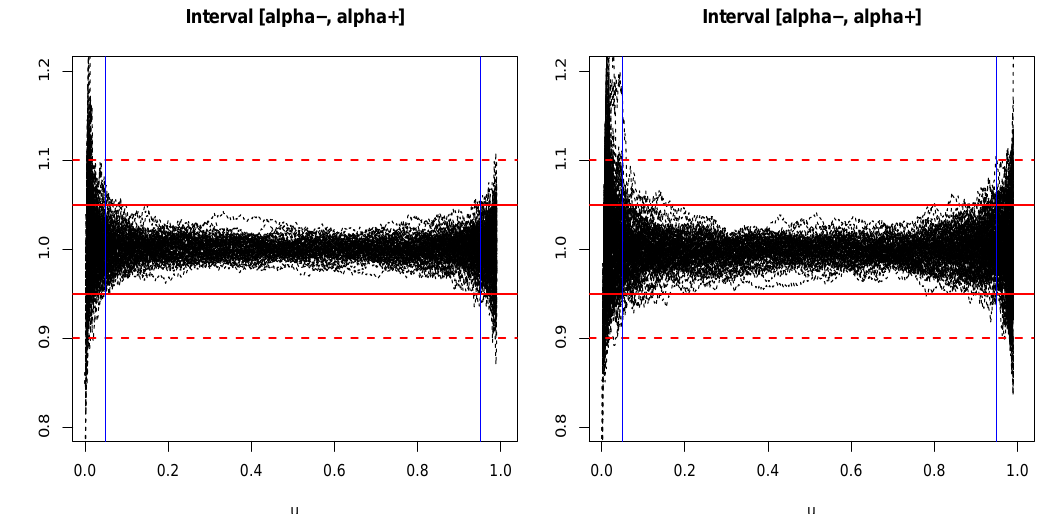
Figure 1. 100 paths of ratios a ( u ) = lnb δ ( u ) / lne δ ( u ) , for simulated bivariate data with Gumbel copula of parameter θ = 2 (Kendall’s τ = 0 . 5 ) in the case where the data size is n = 3500 (left) or n = 2000 (right). Here we choose bounds α + = 0 . 9 and α − = 1 . 1 (dashed horizontal lines) and α + = 0 . 95 and α − = 1 . 05 (full horizontal lines). The blue vertical lines represents the considered interval I = [ 0 . 05 , 0 . 95 ] ⊂ [ 0 , 1